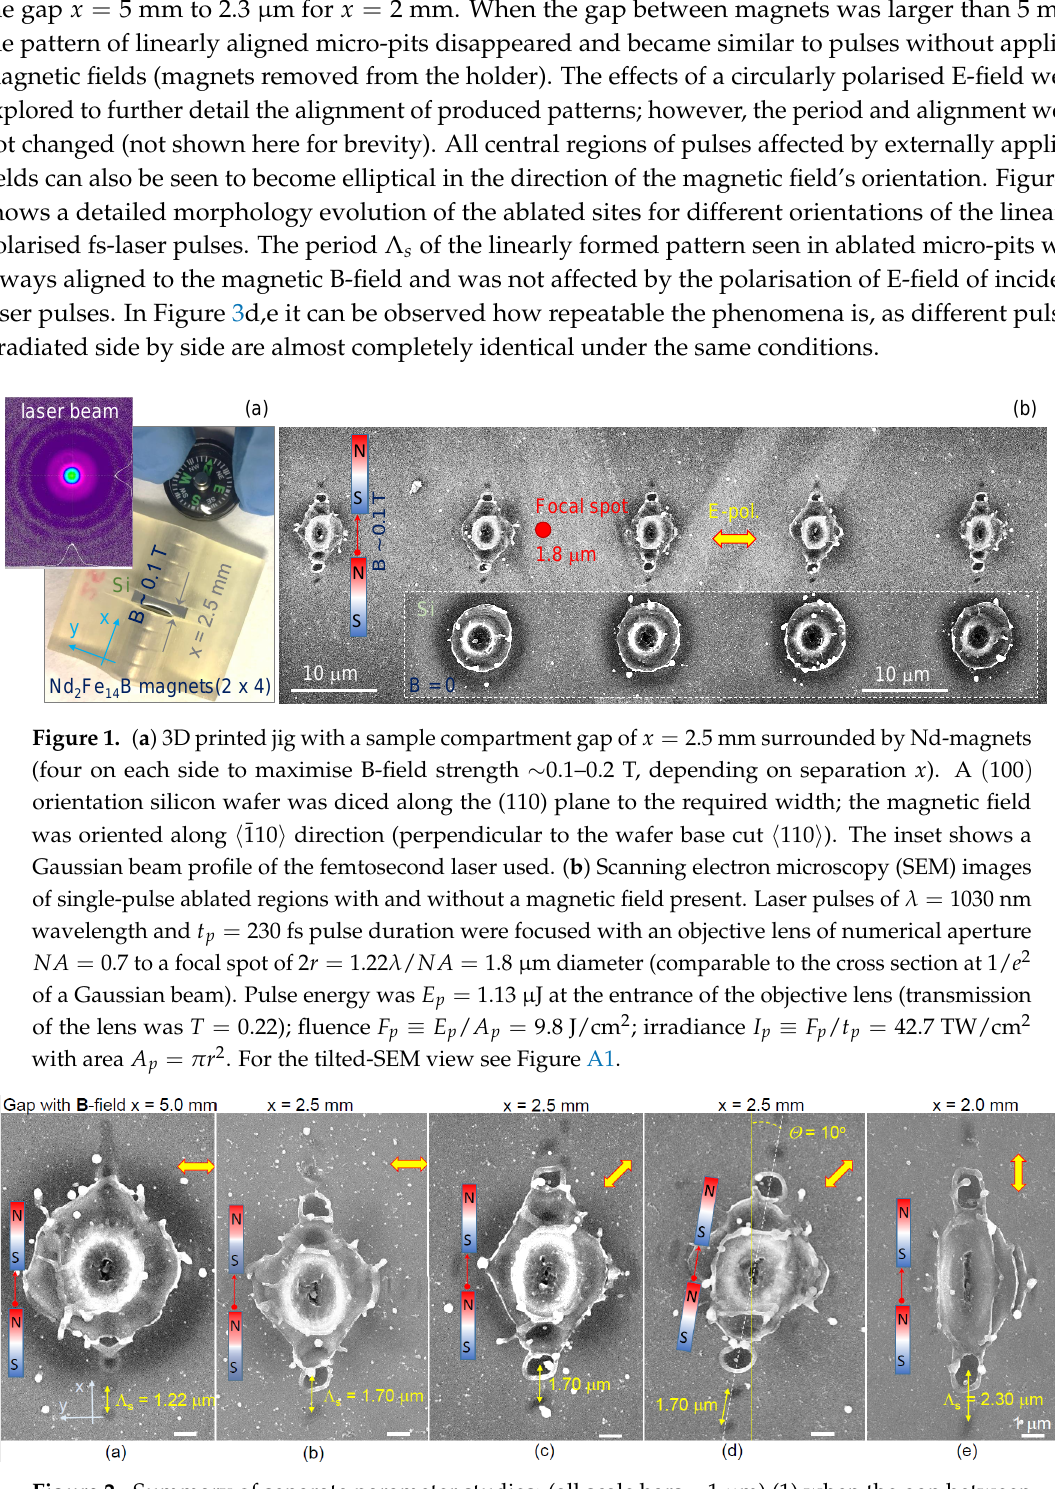
Figure 2. Summary of separate parameter studies: (all scale bars = 1 µ m) (1) when the gap between magnets is x > 5 mm, seen in ( a ), subsequent ablation patterns are barely observed, similarly to having no magnetic field B = 0 (Figures 1b, 4a, and A1); (2) polarisation rotation changes pattern only slightly (( b ) versus ( c )); (3) rotation of magnetic field clearly has the strongest effect of orientation of SPP pits (( c ) versus ( d )); (4) (( a ) to ( e )) period Λ s of SPP pattern depends on the gap x (magnetic field strength). Pulse energy and focusing conditions were like those seen in Figure